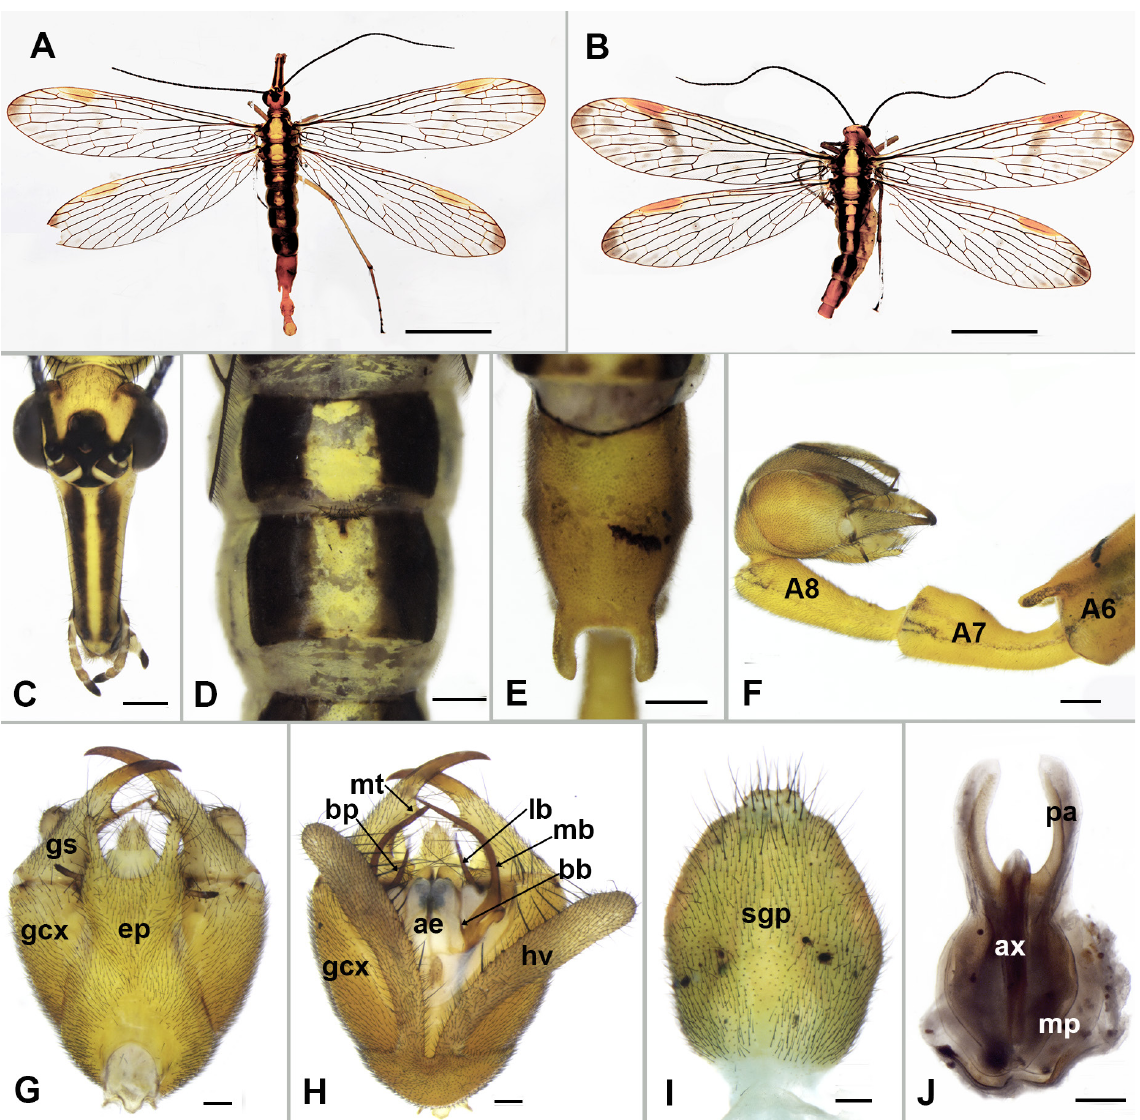
Fig. 4. Dicerapanorpa zhengkuni sp. nov. A . ♂, holotype, dorsal view, NWAU. B . ♀, paratype, dorsal view, NWAU. C . Head, frontal view. D . ♂, abdominal segments III and IV, showing the notal organ,